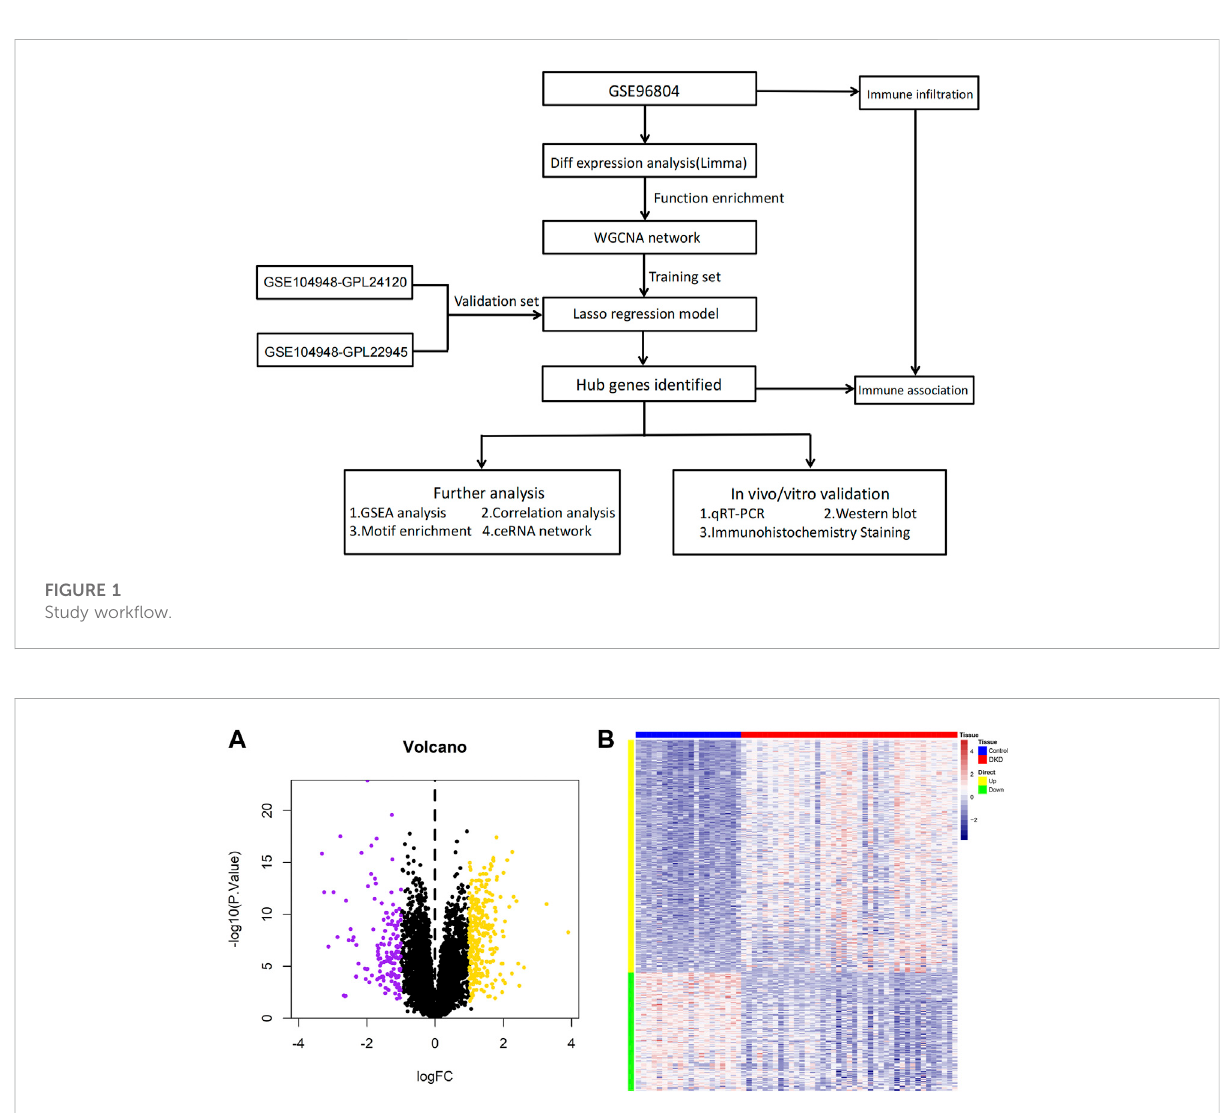
FIGURE 2 Identi fi cation of differential genes in DKD. (A) Volcano plot of the differential expression of GSE96804. Purple and yellow indicate the down- regulation and upregulation of differential expression, respectively (screening conditions: p < 0.05 and |Log2FC| > 0.585). (B) Heatmap of differential gene